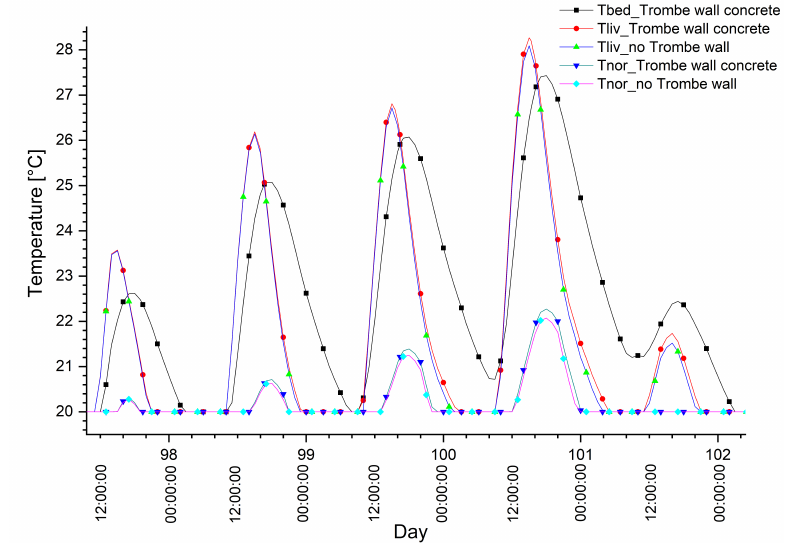
Figure 13. Comparison of temperatures in the living room and north-facing rooms for the case of the bedroom equipped both with and without the concrete solar Trombe